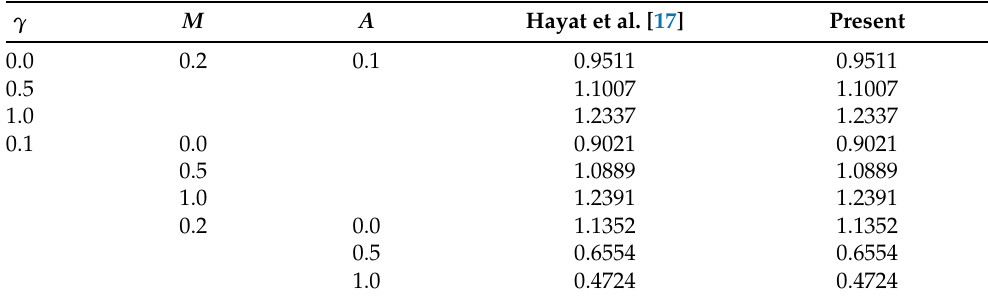
( 0 ) increases while elevating 1 ( 0 ) for different parameters. 1